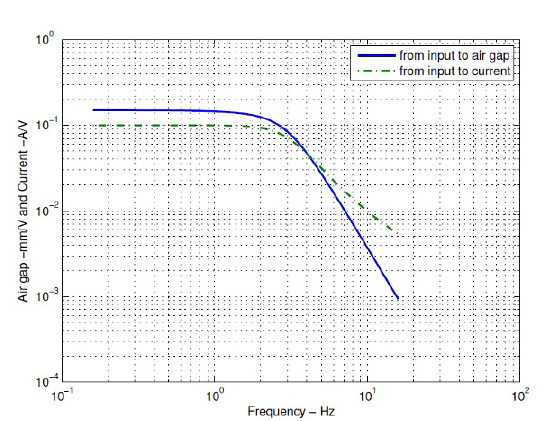
Figure 3. Deterministic input to the suspension with 5% gradient at a vehicle speed of 15 ms − 1